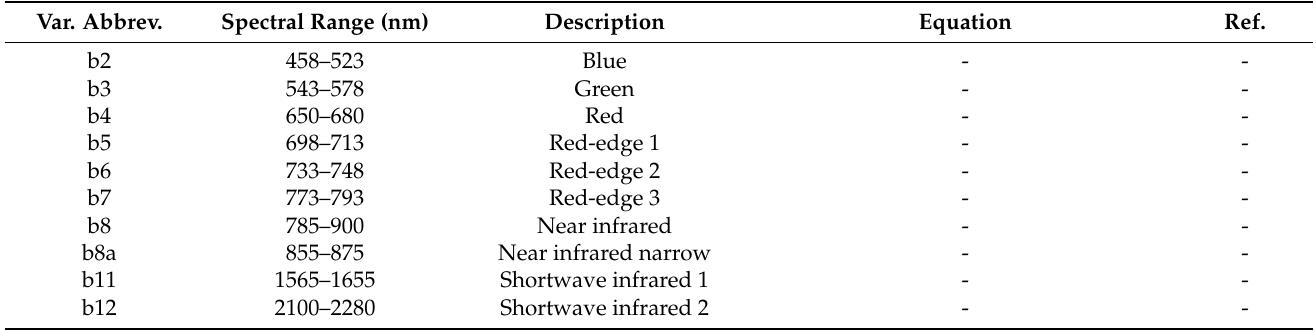
Table 2. Spectral bands and VI according to Sentinel-2 satellite imagery from leaf-on and leaf-off periods used as predictor variables in ensemble models of α -diversity